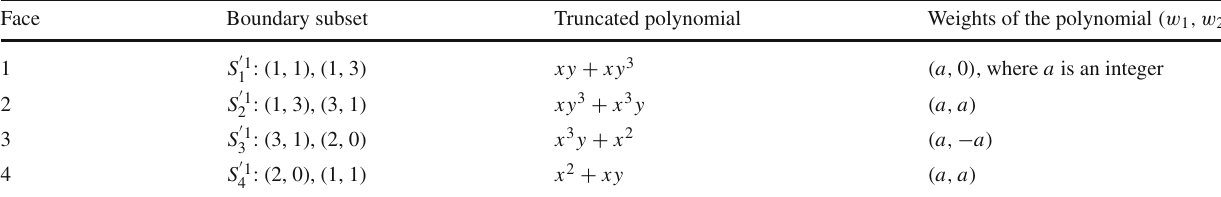
Table 1 A table showing the boundary subsets and the associated normals of Newton polytope Face Boundary subset Truncated polynomial Weights of the polynomial (w 1 ,w 2